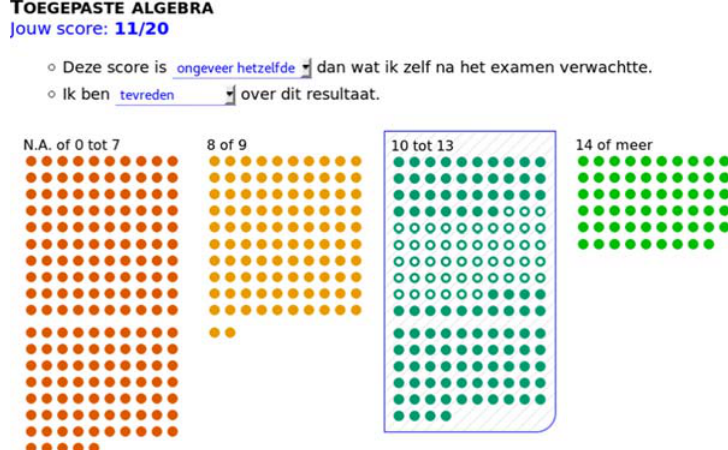
background pattern. After pressing the button to receive a more precise positioning, dots of students with the same score are marked